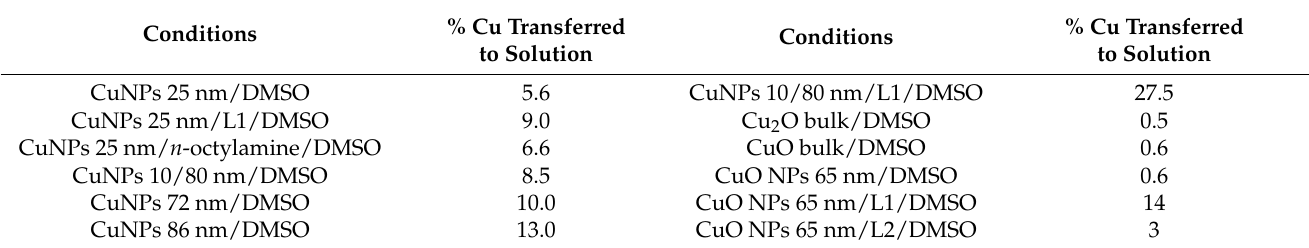
Table 7. Studies on leaching of copper from copper catalysts 1